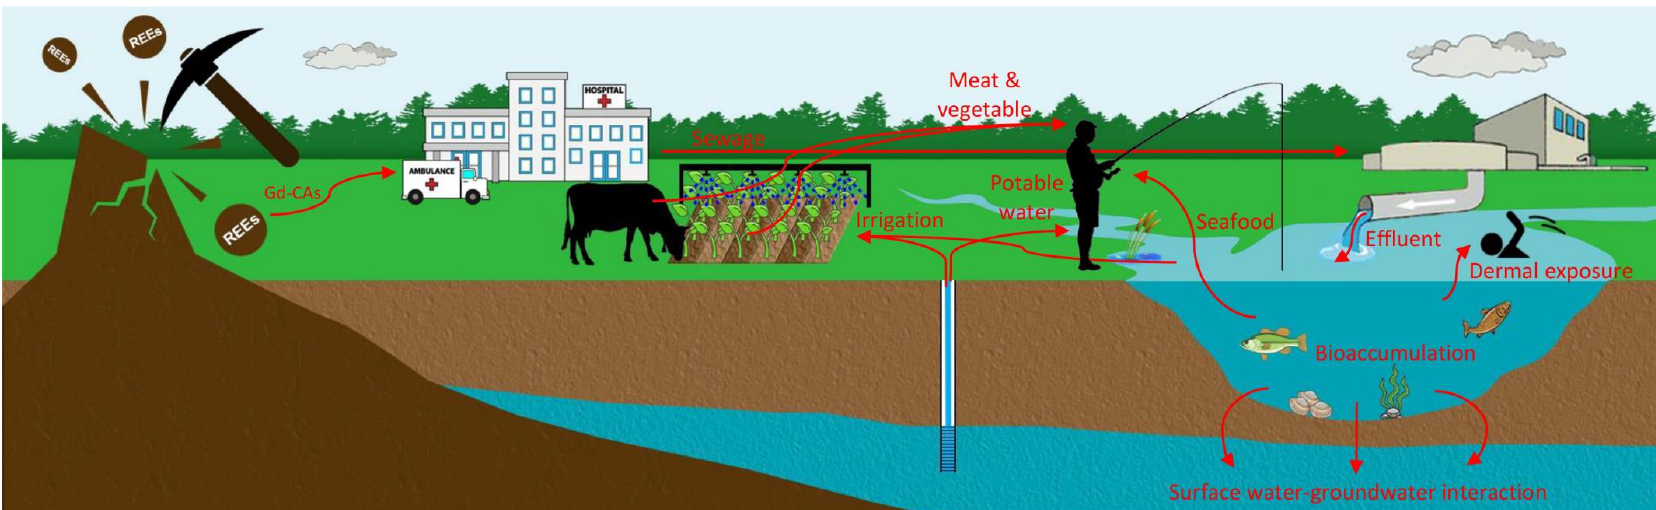
Figure 7. A simplified diagram demonstrating various probable pathways that excreted gadolinium chelates can enter our food chain. To date, anthropogenic Gd has been detected in hospital sewage, WWTP effluent, surface water, groundwater, and tap water. Bioaccumulation of various Gd-CAs in different aquatic species should be further investigated to reach unanimous agreement. Whilst the accumulation of Gd contrast agent has not been reported in fish, vegetables, and livestock, it is worth investigating to enhance our well-being. Besides, exposure through dermal and ingestion pathways should be evaluated.